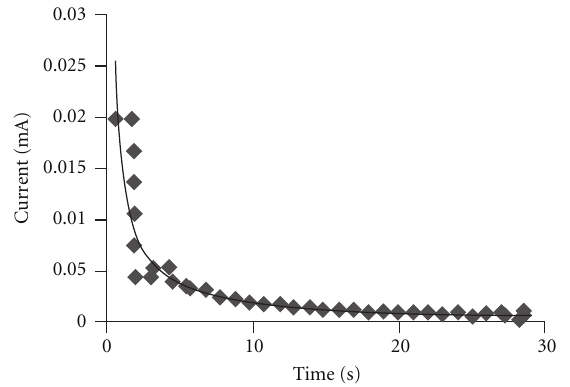
Figure 5: Discharge curve of a cell containing 500 Fe(OH) 2 and 500 Mn(OH) 3 attached to gold electrodes by deposition at +500 mV in the presence of TGA. The solid line is an exponential fit to the data and was used to calculate that 90 µ coulombs transferred through the